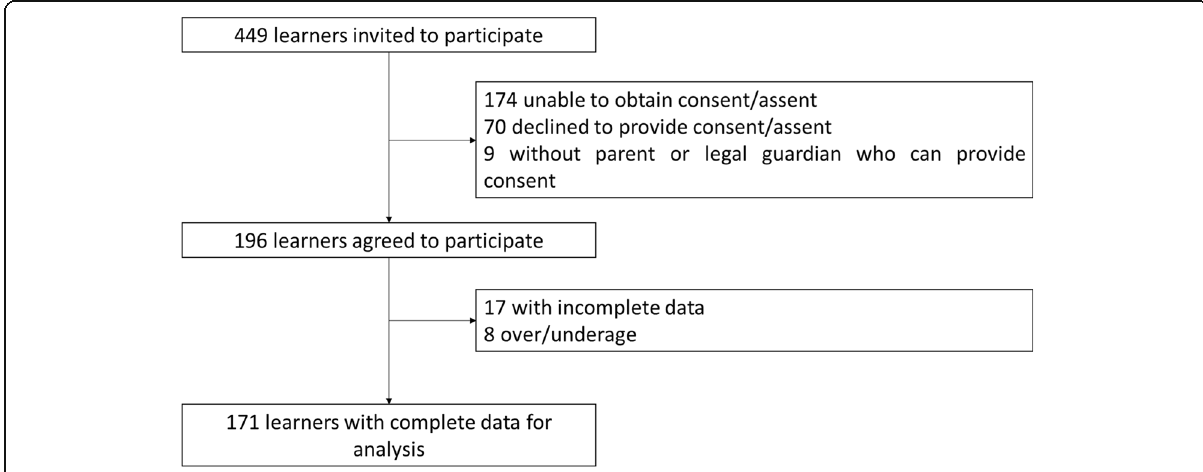
Fig. 1 Flow of participant inclusion in the